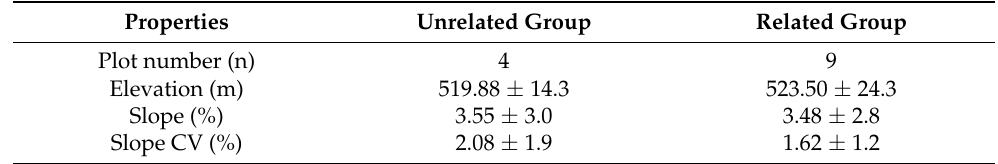
Table 5. Mean values and standard deviation of the geomorphological properties of the 13 plots. The values have been grouped considering the agreement with the NDVI.